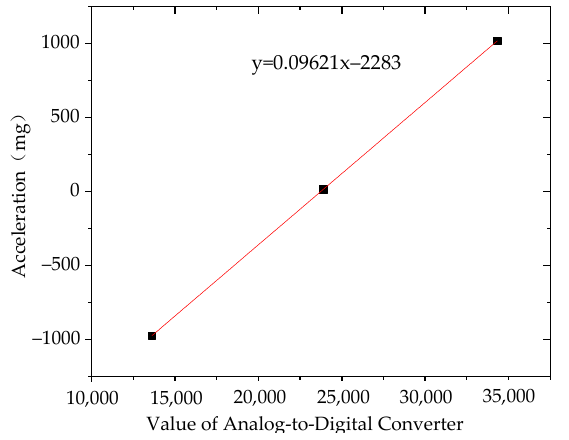
Figure 16. Sensor No. 1.